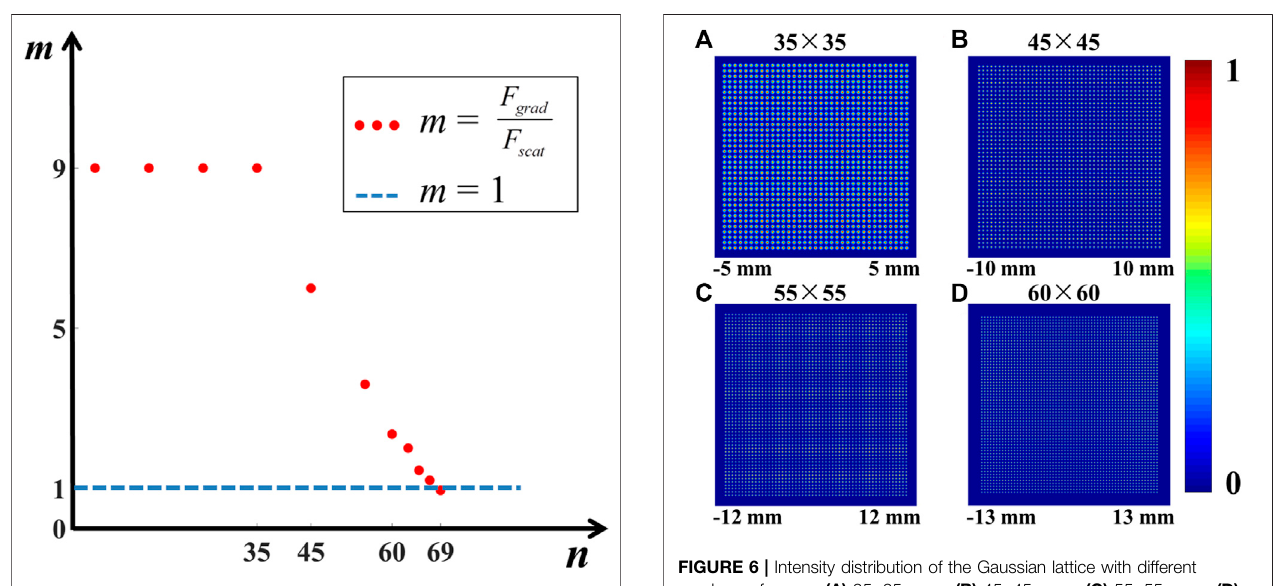
FIGURE 5 | Order of magnitude m with different numbers of Gaussian lattices n .